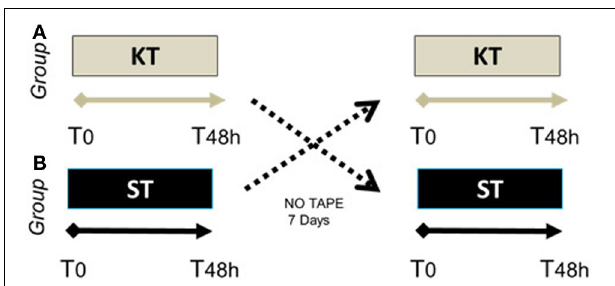
FIGURE 1 | Randomized crossover case control study schema. Group (A) ( n = 6), SCI patients who underwent 48h of KT, followed by 48h of ST